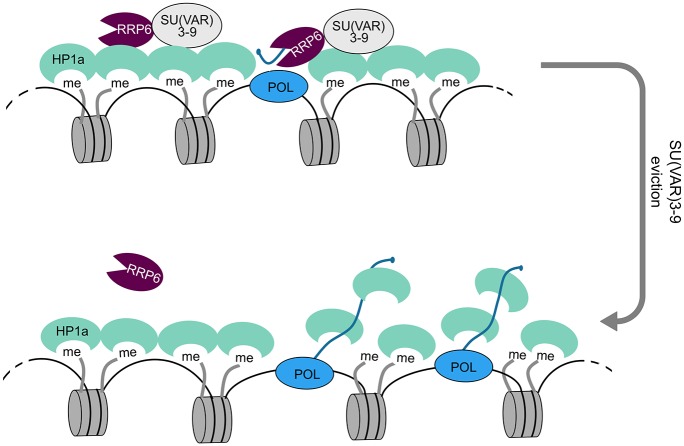
A model for the role of RRP6 in the maintenance of heterochromatin packaging.Heterochromatin domains are characterized by high levels of H3K9me2 and by the presence of HP1a and SU(VAR)3-9. Our results show that RRP6 interacts with SU(VAR)3-9 and that this interaction is important to tether RRP6 to the heterochromatin. Transcripts derived from sporadic transcription of heterochromatic repeat sequences are kept at low levels by RRP6 degradation. Failure to degrade such transcripts results in increased levels of chromatin-associated transcripts, increased binding of HP1 to the chromatin-associated transcripts, and chromatin decondensation.